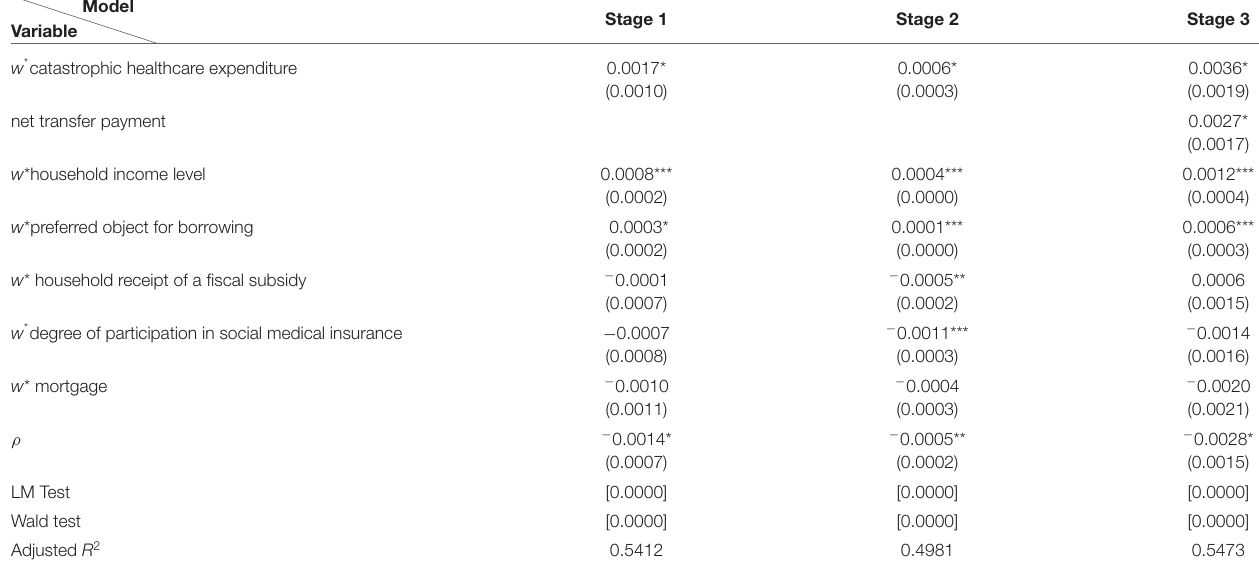
TABLE 3 | Regression